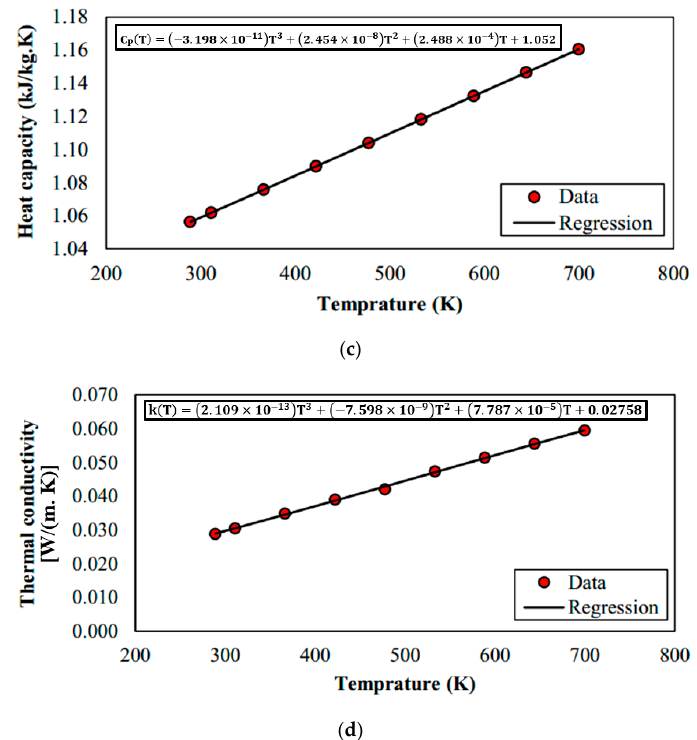
Figure 3. The thermophysical properties of the exhaust gas flow in the fire tube as a function of gas temperature: ( a ) density, ( b ) viscosity, ( c ) heat capacity, and ( d ) thermal conductivity